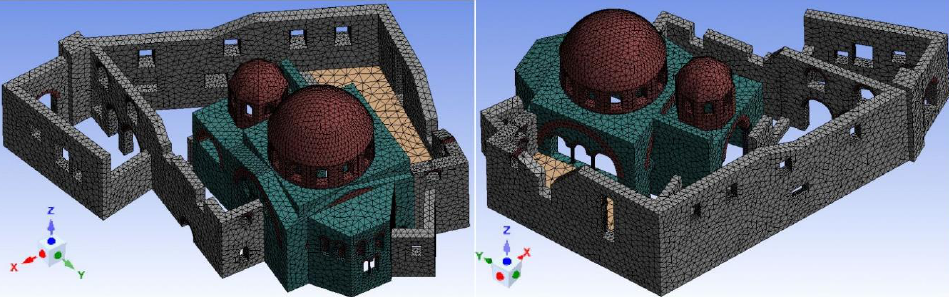
Figure 12. Meshed finite element analysis model of the structure.